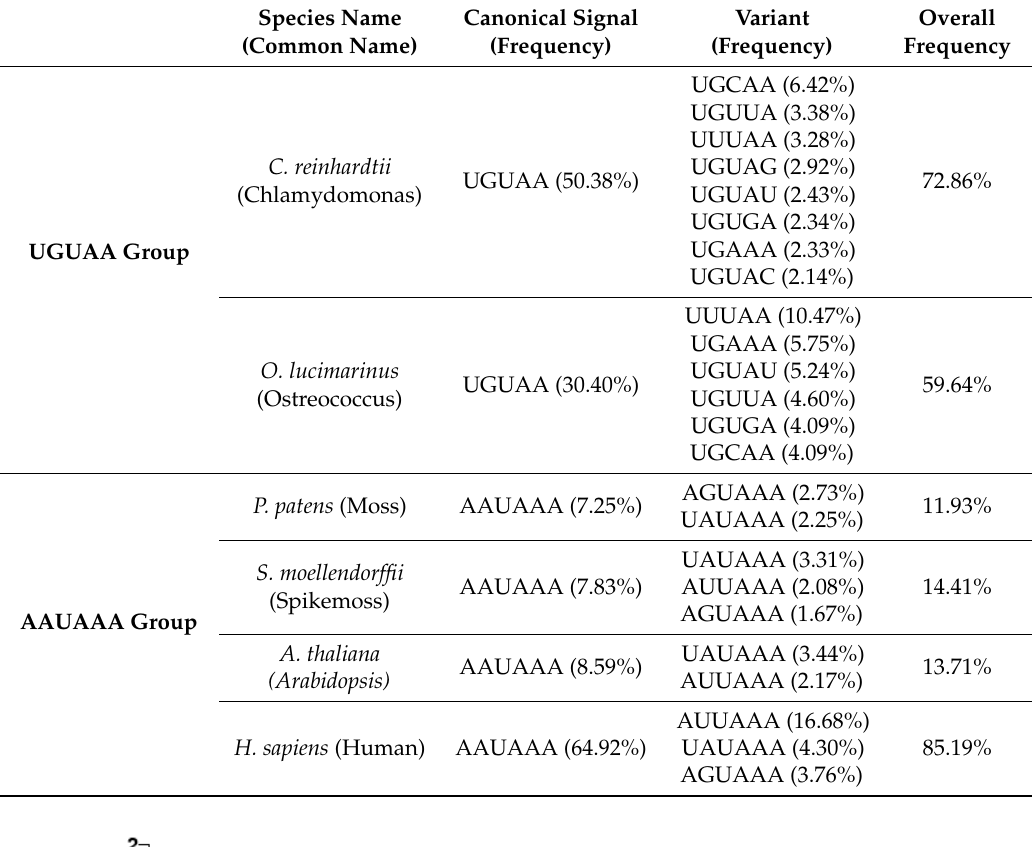
Table 2. The frequencies of UGUAA and AAUAAA and their single nucleotide variants.